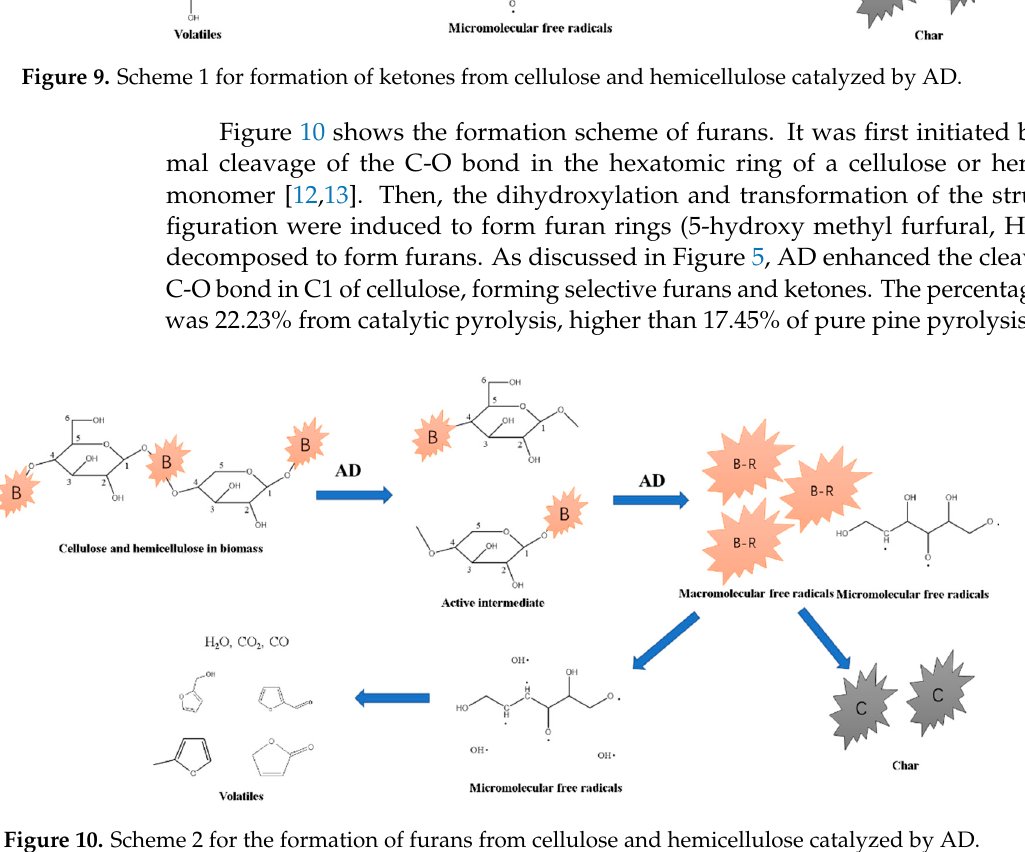
Figure 10. Scheme 2 for the formation of furans from cellulose and hemicellulose catalyzed by